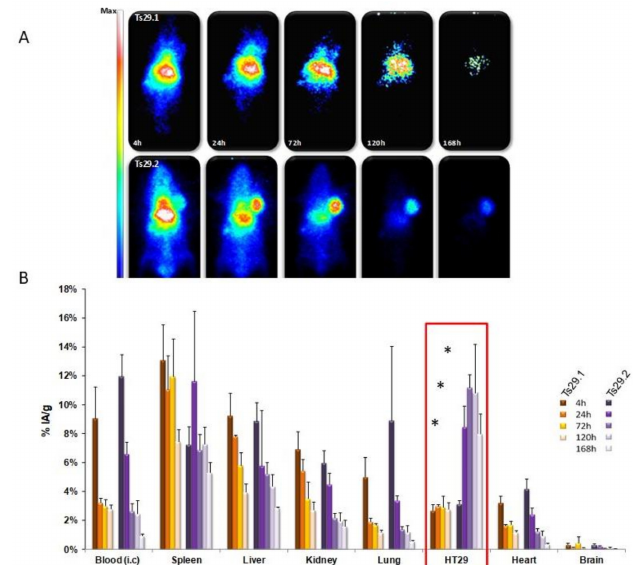
Figure 3. In-vivo selection of [ 111 In]DOTA-Ts29 antibodies for imaging and therapy in mice with HT29 colon carcinoma xenografts. Nude NMRI mice with HT-29 tumors were injected (i.v.) with 3.7 MBq of [ 111 In]DOTA-Ts29.1 (upper images) or [ 111 In]DOTA-Ts29.2 (lower images), which were imaged with a planar γ -camera at 4 h, 24 h, 72 h, 120 h and 168 h post injection ( A ). Biodistribution was performed after euthanasia and expressed as the percentage of activity injected per gram of tissue (%AI/g) of [ 111 In]DOTA-Ts29.1 (orange) or [ 111 In]DOTA-Ts29.2 (purple) ( B ). Radioactivity was measured using a γ -counter. Results are presented as the average percentage of injected dose/gram of tissue of three animals for each time point. The error bars represent the standard deviation. Biodistribution difference between the two mAbs: * p < 0.05 Fisher test.